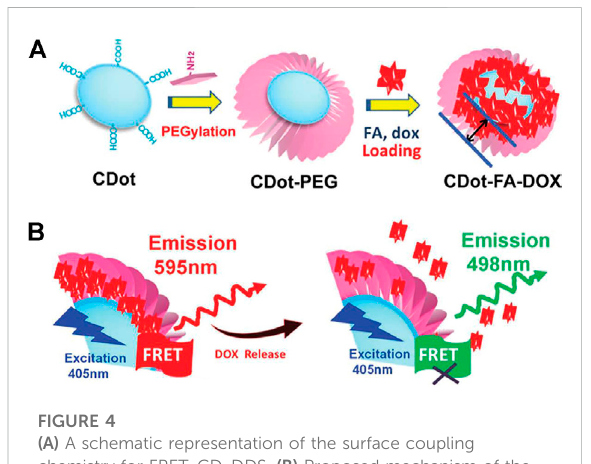
FIGURE 4 (A) A schematic representation of the surface coupling chemistry for FRET-CD-DDS. (B) Proposed mechanism of the FRET-CD-DDS for drug delivery.